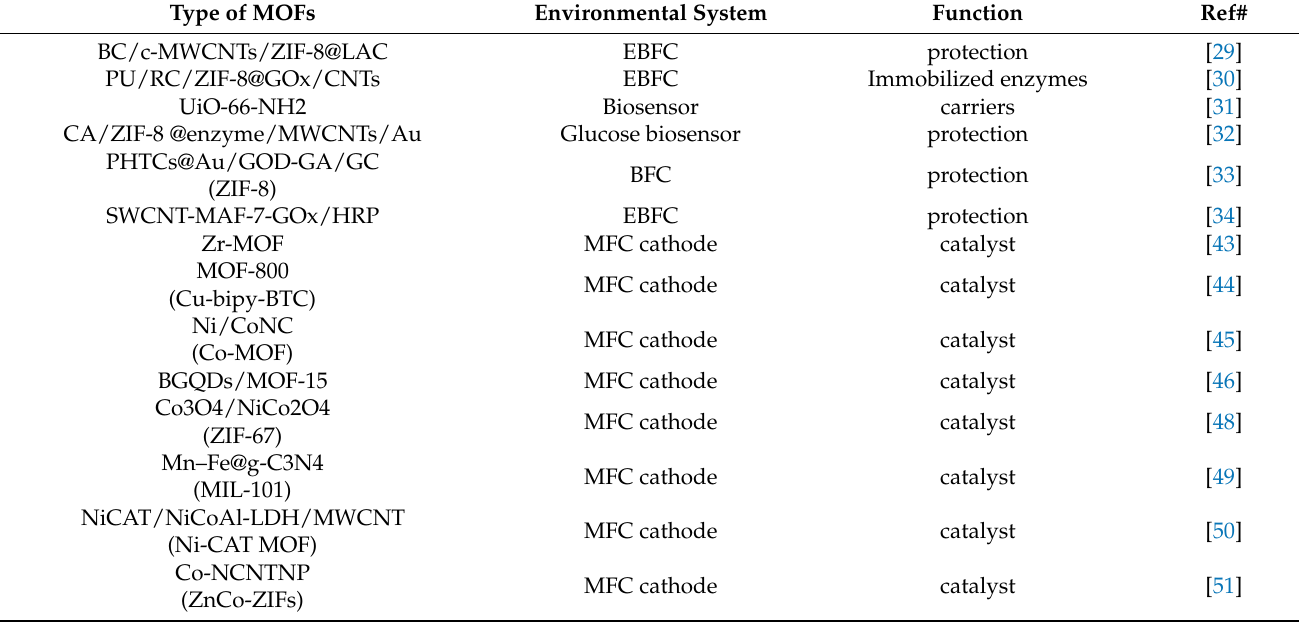
Table 2. MOFs usage and their